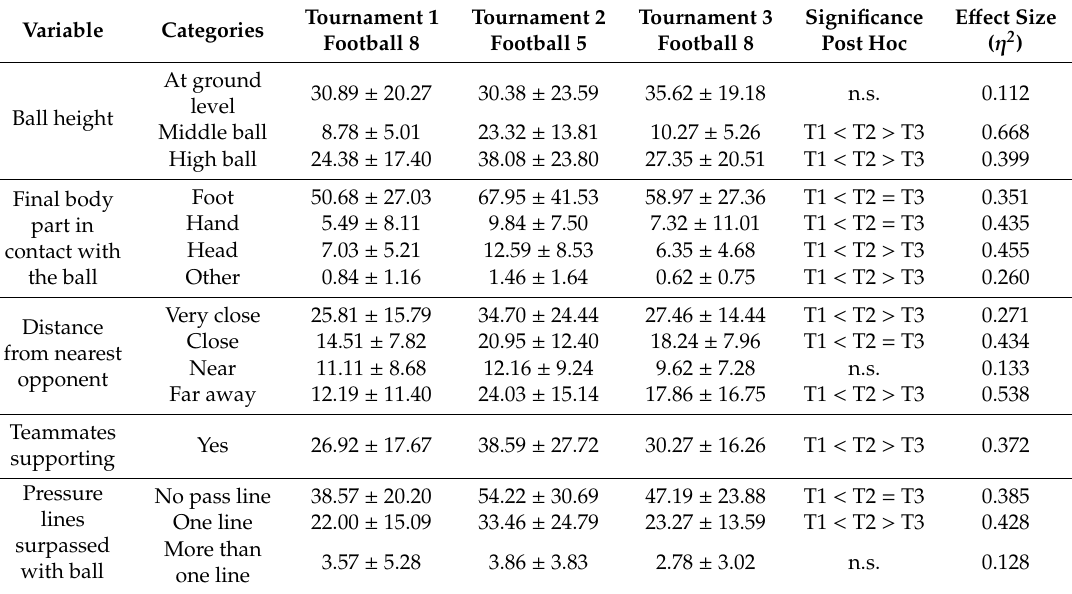
Table 6. Technical–tactical aspects in the finalization of the possession of the